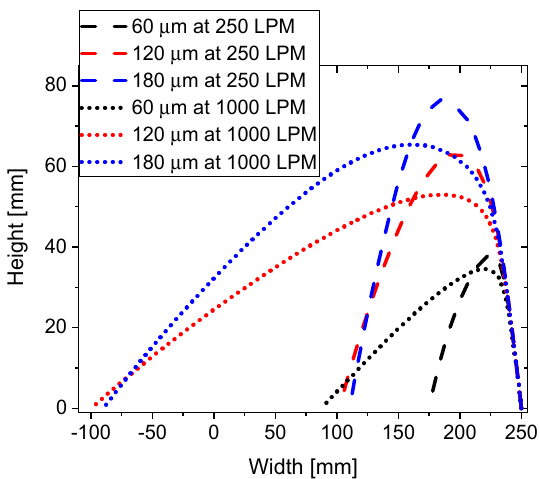
Figure 9. Spatter trajectories for various particle diameters and ejection angles at an ejection speed of 1.5 m/s. Volume flow rate: 250 LPM.